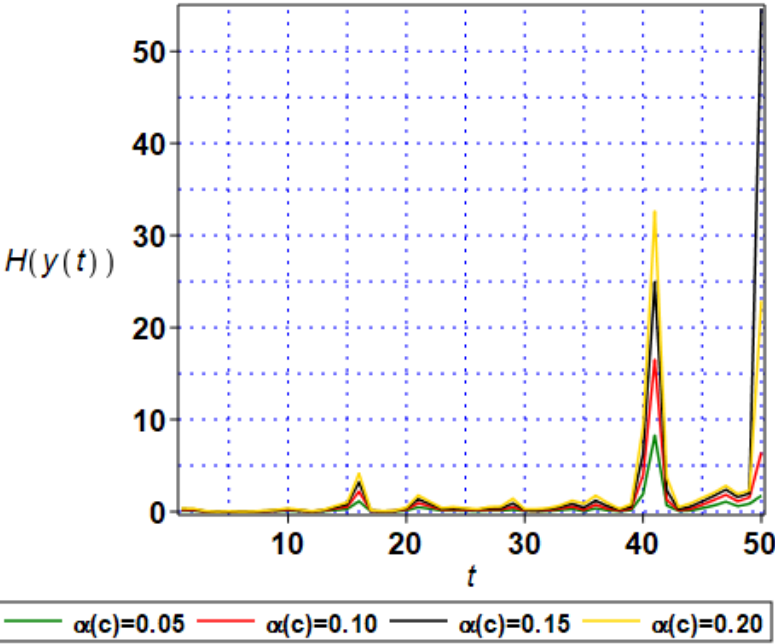
Figure 6. Shannon entropies logarithm time fluctuations for Gaussian structural damping.